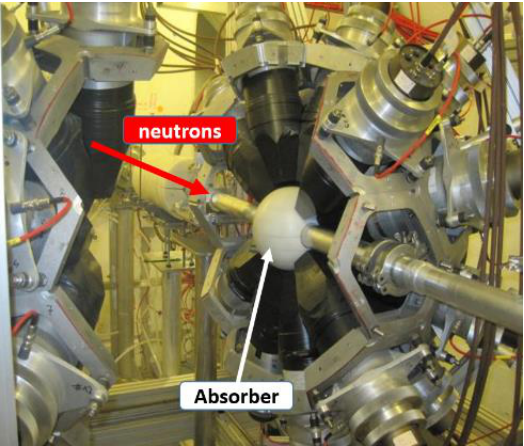
Fig. 4. The n_TOF Total Absorption Calorimeter.